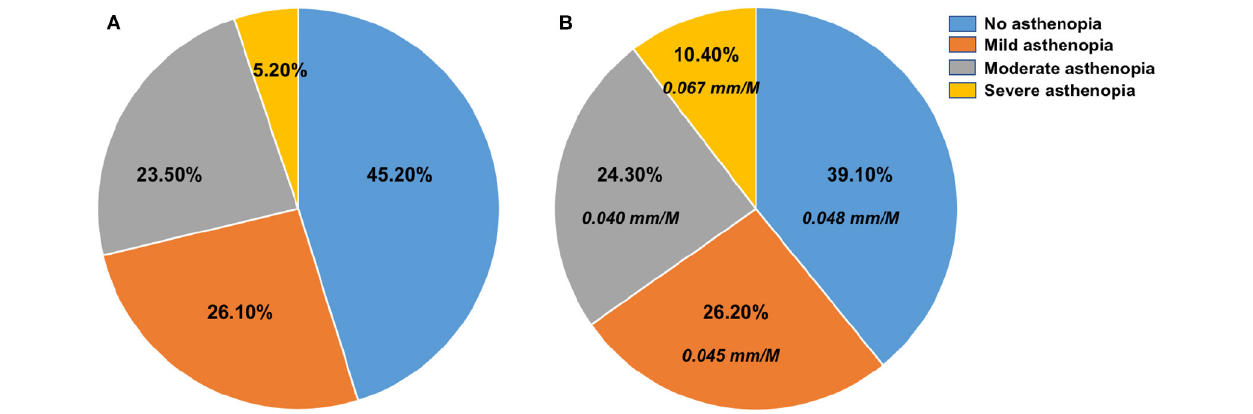
FIGURE 2 | Proportion of asthenopia before the COVID-19 pandemic and after the strict home confinement during the COVID-19 pandemic (A) asthenopia before the COVID-19 pandemic; (B) asthenopia after the strict home confinement during COVID-19 pandemic and monthly growth rate of eye axial length in different degrees